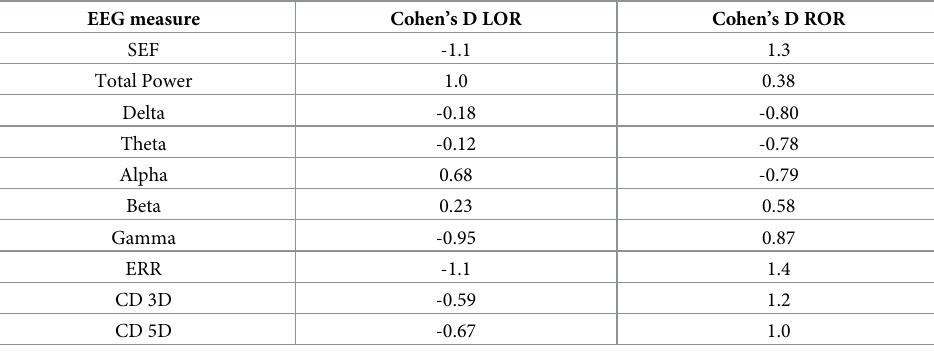
Table 3. Summary of Cohen’s D for measured values before and after loss of response and recovery of